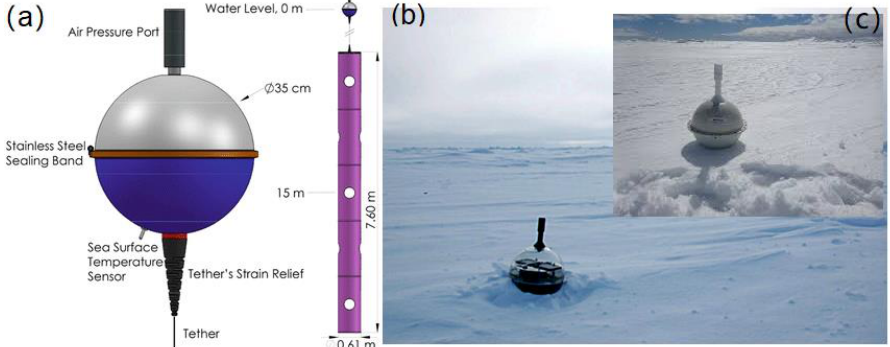
Figure 11. ( a ) Illustration of a typical IABP buoy, with a surface temperature sensor near the bottom [50], Adapted with permission from ref. [50], Copyright 2019, Luca R. Centurioni. Field photos of